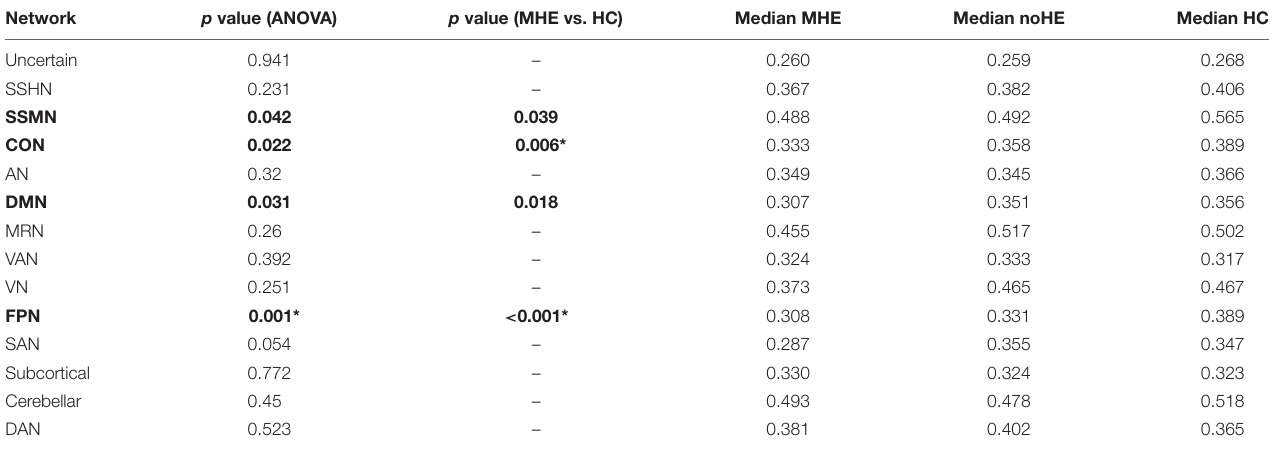
TABLE 3 | The differences in average network connection-stability scores among MHE, noHE and HC groups. Network p value (ANOVA)